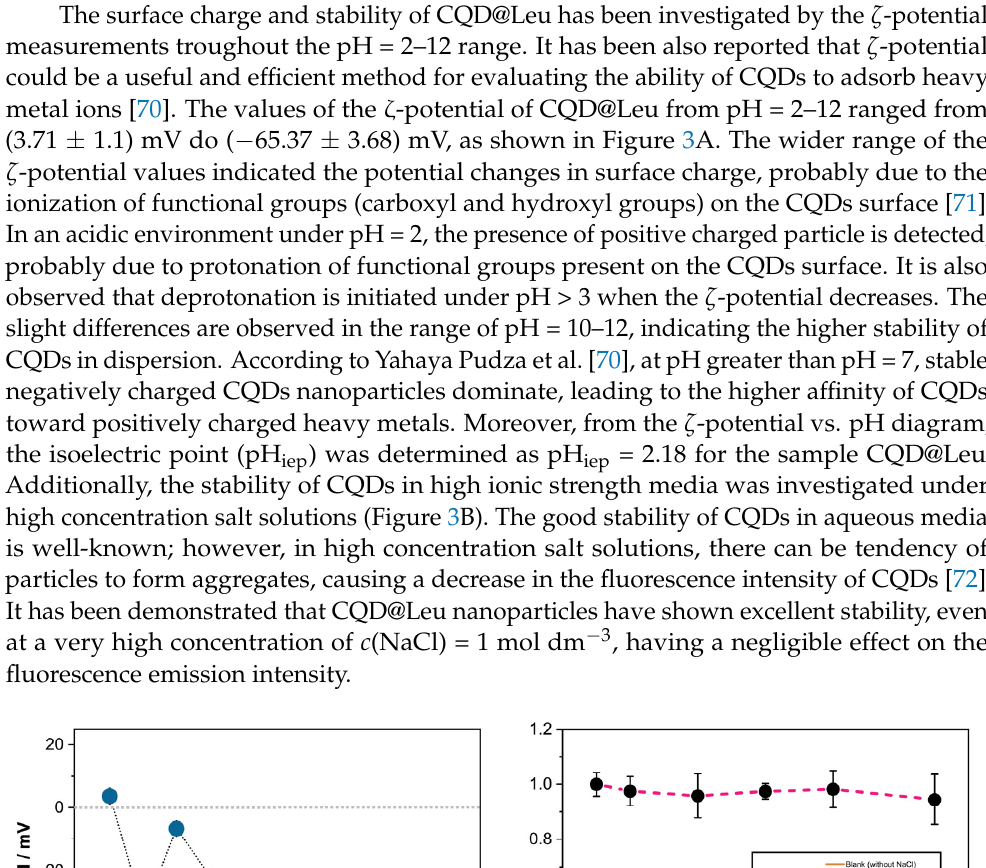
Figure 4. FTIR spectra of ( A ) CQD@Blank and ( B ) CQD@Leu with corresponding vibrational modes. Based on the PXRD results (Figure 5), the physical and structural characteristics of CQDs could be described. For the analyzed sample CQD@Leu, the XRD pa tt ern demonstrated the existence of a broad peak centered at 2 θ = (20.14 ± 2.84)°, which could con fi rm the amorphous nature of prepared CQDs [71,74]. The calculated interlayer spacing of 0.44 nm for the sample CQD@Leu, compared to 0.34 nm of graphite, indicated and con fi rmed the presence of amorphous nature and low crystallinity of CQDs, probably caused by surface functionalization [75]. According to the Scherrer equation, the average crystallite size was calculated to be 1.1 nm, while the mean size determined from the TEM images was estimated to be 15.2 nm. These fi ndings indicate that peak broadening presented on the XRD di ff ractogram could be a result of the presence of amorphous structure.